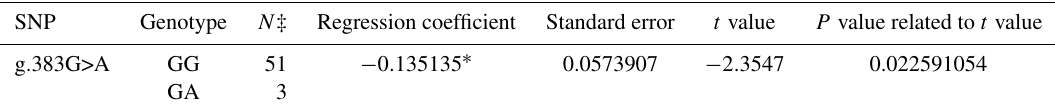
Table 5. The SNPs located in the first exon and intron in the BMP15 gene of the Da˘glıç breed, with their significance levels and calculated regression coefficients. SNP Genotype N ‡ Regression coefficient Standard error t value P value related to t value g.383G>A GG 51 − 0 . 135135 ∗